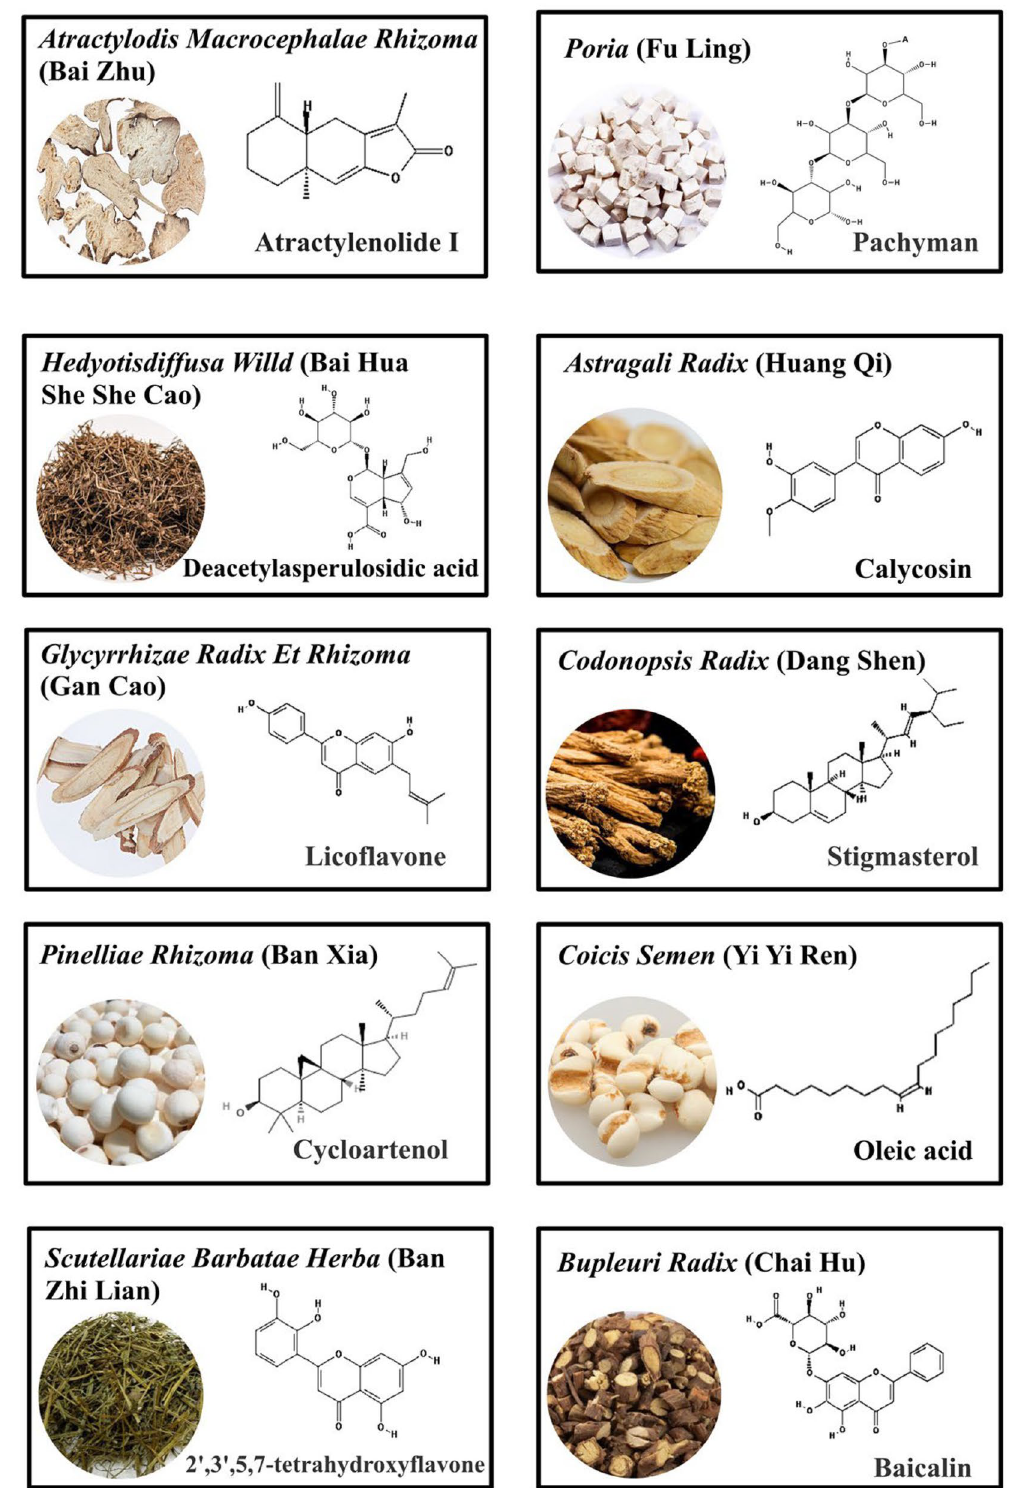
Figure 1. The top 10 herbs most frequently applied in treatment of PDAC and their chief chemical components with well-defined pharmacological activities. Chemical structures were downloaded from the Traditional Chinese Medicine Systems Pharmacology database and PubChem (https:// pubch em. ncbi. nlm. nih. gov/). The chemical component of Poria (Fu Ling) shows the main chain of pachyman, including 50 β -(1 → 3) bound glucose units. “A” represent additional 47 β -(1 → 3) bound glucose